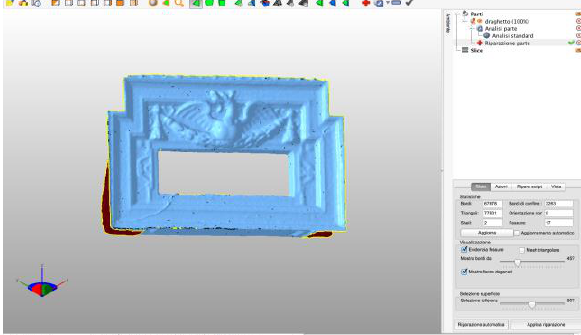
Figure 12. Netfabb: selection of model leaks to be